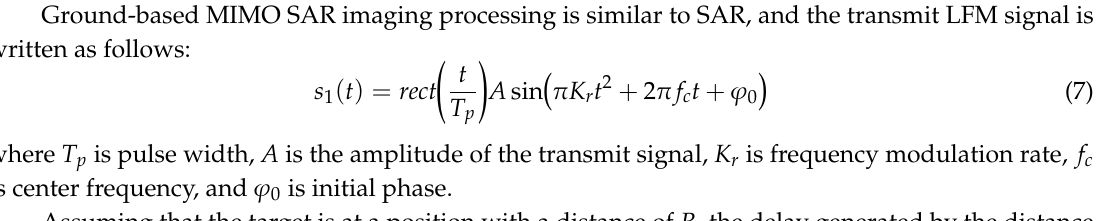
Figure 7. Schematic diagram of the transceiver antenna array.